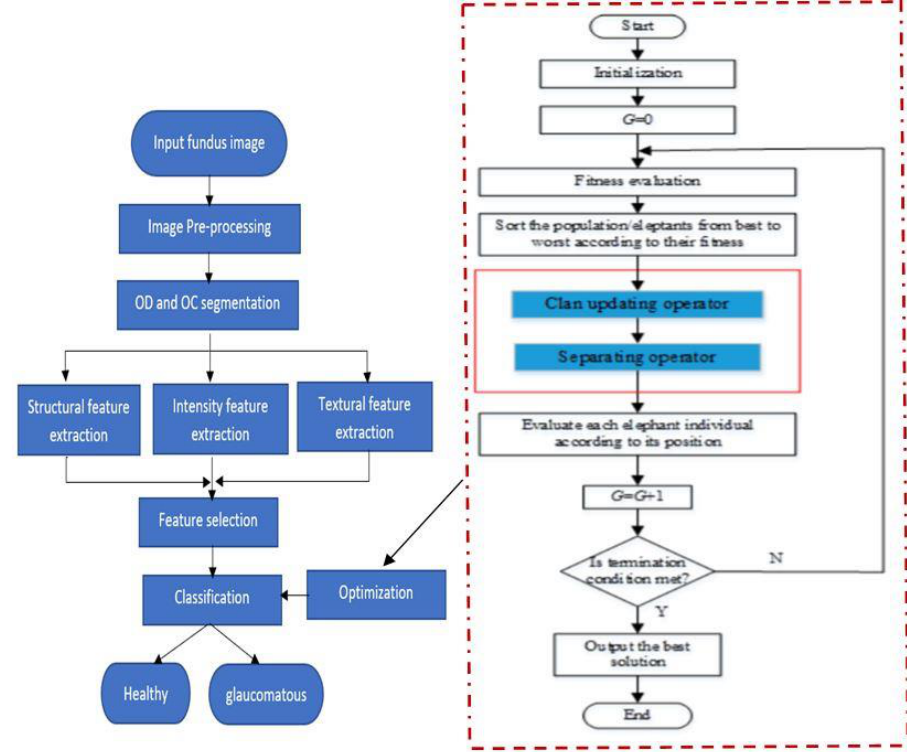
Figure 2. Flow diagram of the proposed approach.